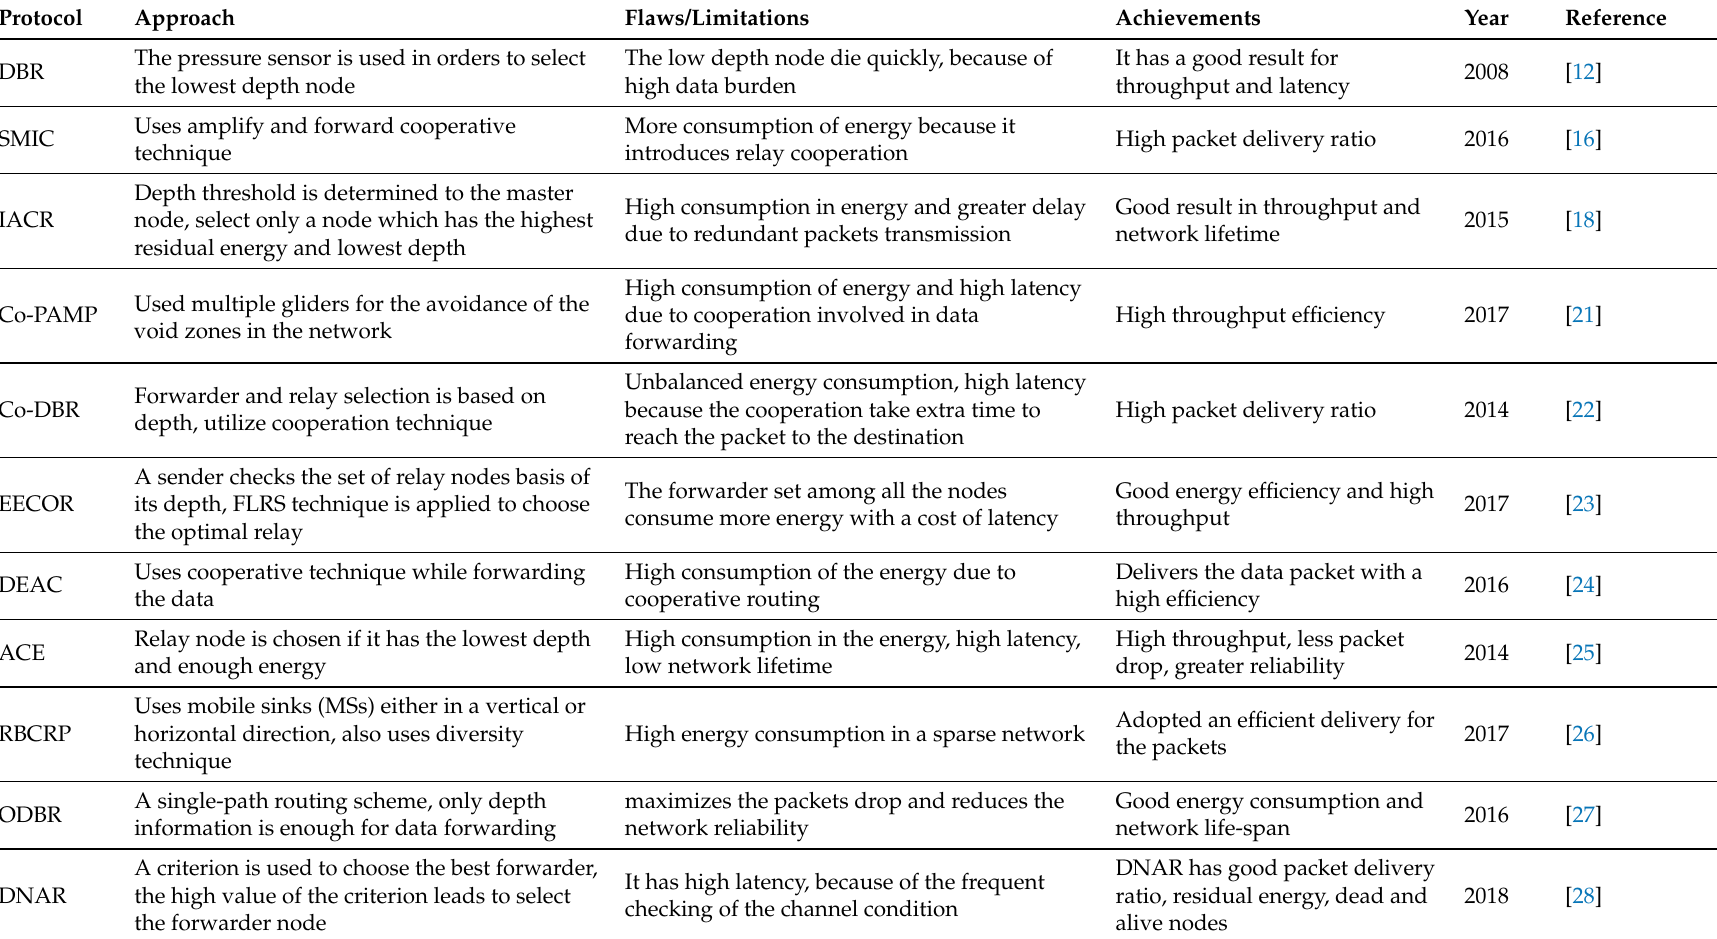
Table 2. The state-of-the-art of routing protocols in underwater wireless sensor networks